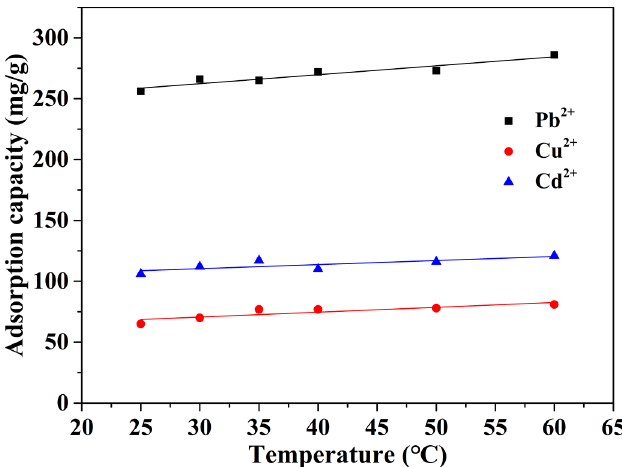
Figure 6. Effect of the environmental temperature on metal ions adsorption. (~50 mg of mp-CA/GO was equilibrated with 50 mL of 1.5 mM Pb 2+ , Cu 2+ , or Cd 2+ solution at different temperatures for 40 min).